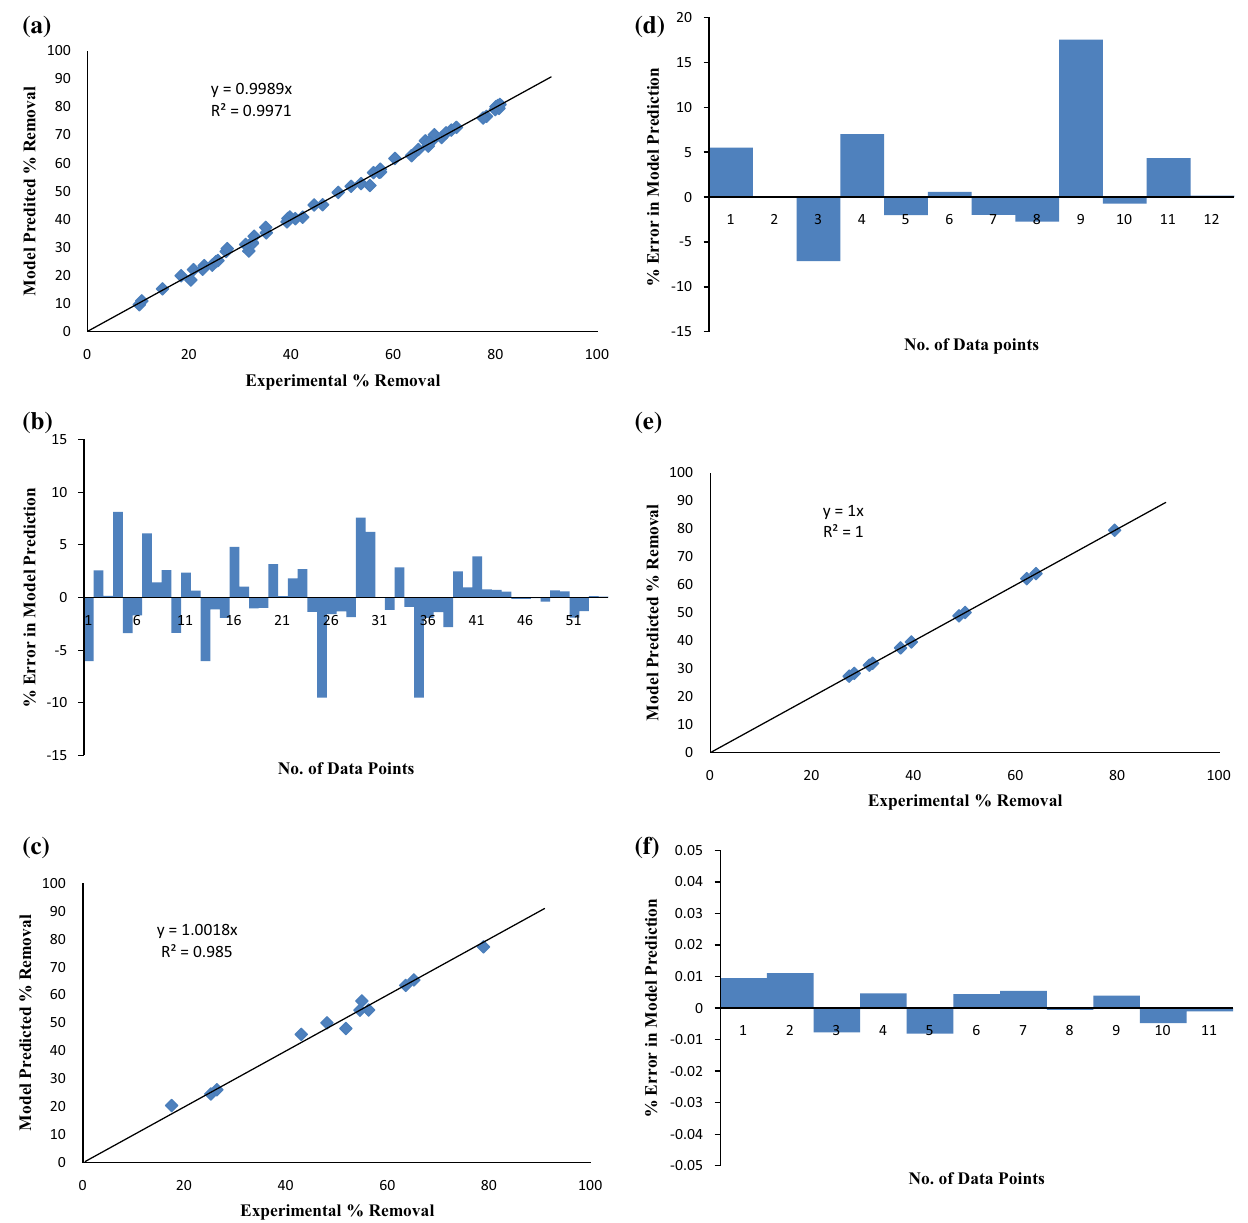
(12 points), e comparison of ANN prediction for unseen data test data set (11 points) and f percentage error in ANN prediction for unseen data test data set (11